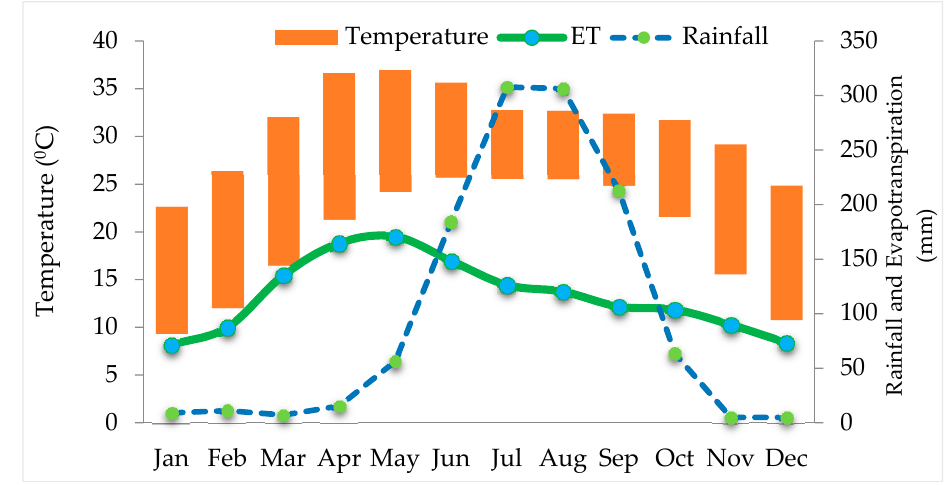
Figure 4. Maximum and minimum monthly temperature, mean rainfall and ET in the Koshi river basin districts of Bihar (1991–2010).